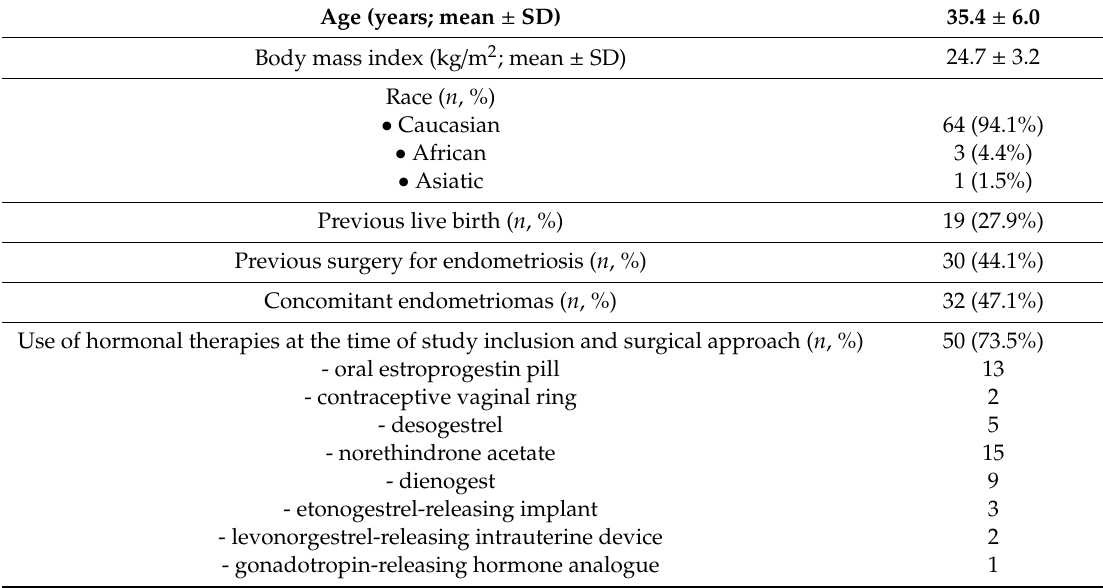
Table 1. Demographic characteristics of the study population ( n =